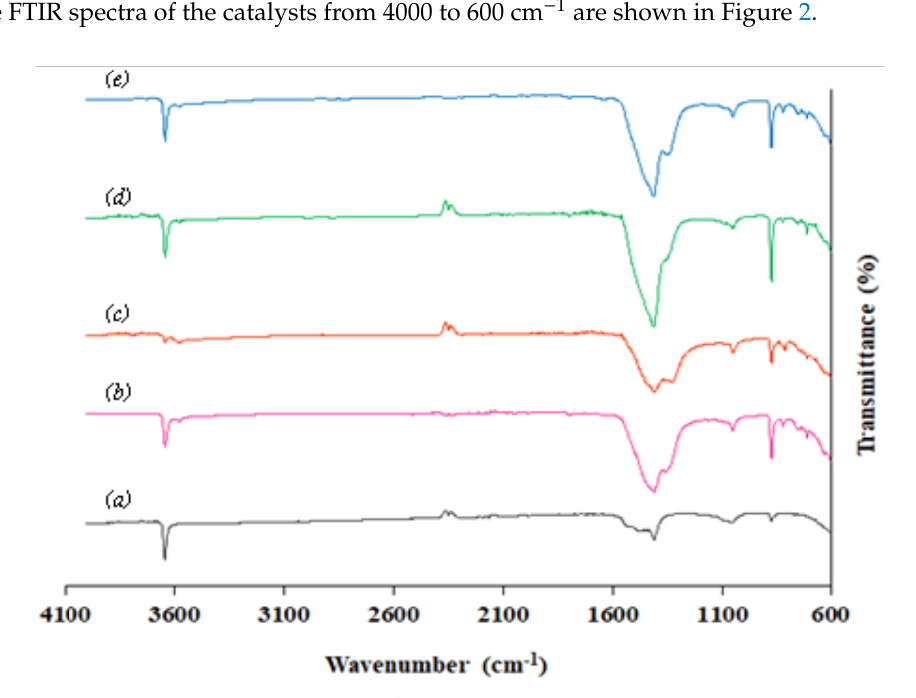
Figure 2. FTIR spectra from 4000 to 600 cm − 1 of ( a ) calcined eggshell, ( b ) Fe 5%, ( c ) Fe 15%, ( d ) Cu 5%, and ( e ) Cu 15%.